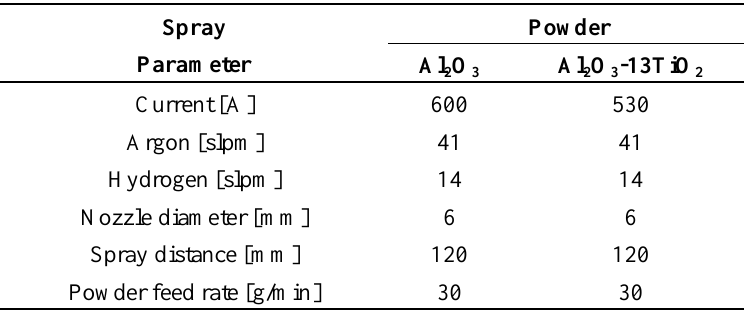
Table 1. Spray parameters for plasma spraying (APS).